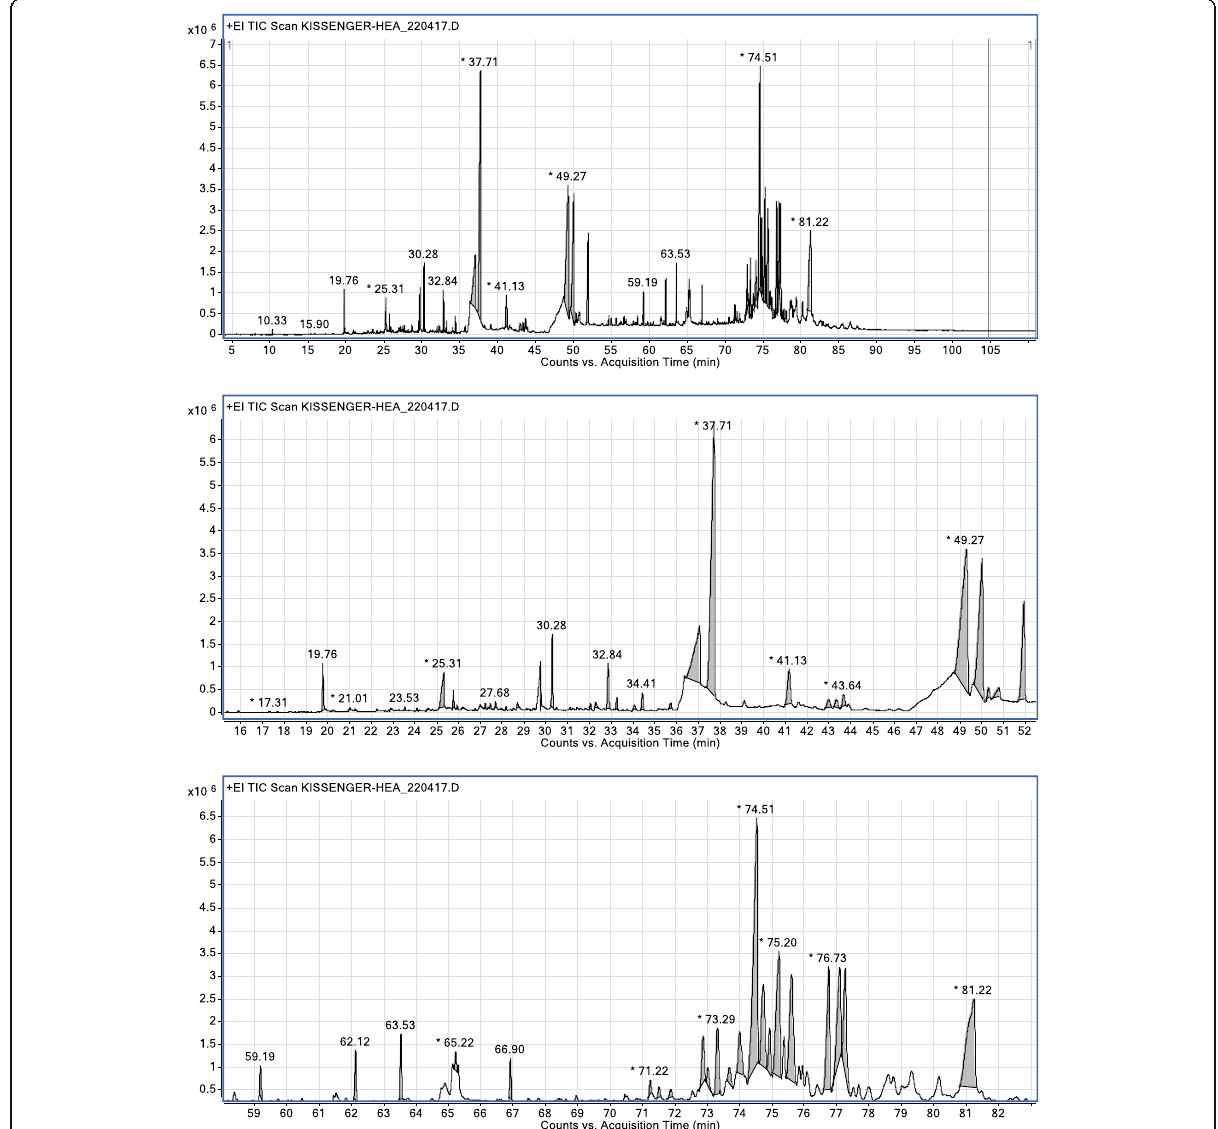
Fig. 1 Chromatogram of Phytoconstituents in Spondias mombin Linn. stem bark